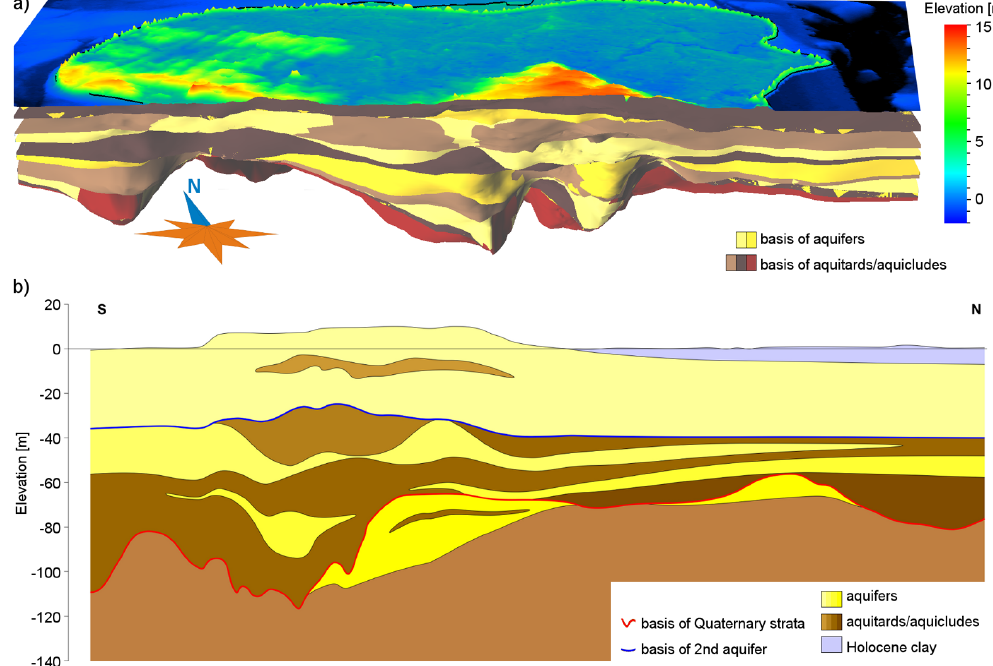
Fig. 10. Final 3-D model: (a) 3-D view into the model; and (b) 10km-long cross-section through the 3-D model. The location of the section is shown in Fig.